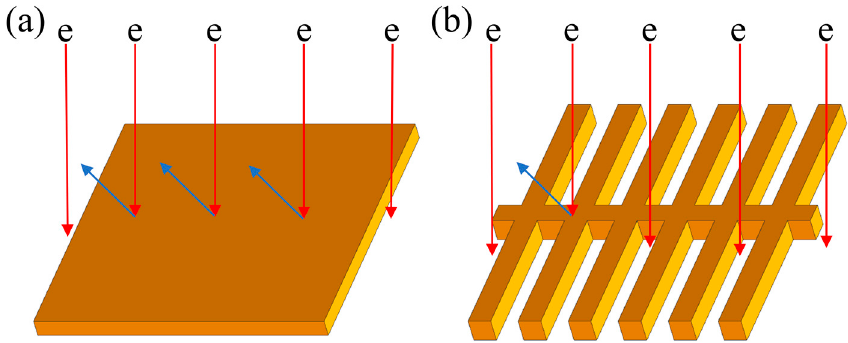
Figure 4. The hindrance of ( a ) lamellar and ( b ) fibrous eutectic Si to